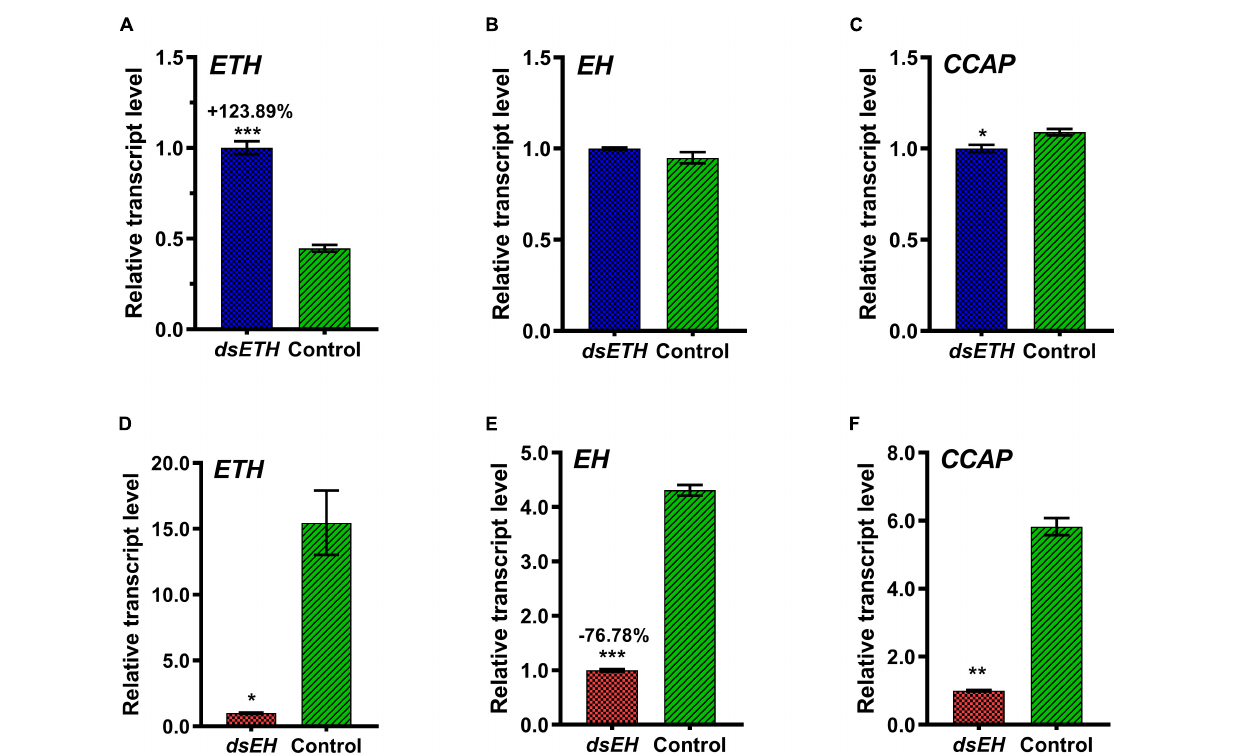
FIGURE 5 | Relative transcript levels of ETH (A) , EH (B) , and CCAP (C) in thoracic ganglia of dsGFP and dsETH -injected crabs at D2 stage were measured. Also, relative transcript levels of ETH (D) , EH (E) , and CCAP (F) in the thoracic ganglia of dsGFP and dsEH -injected crabs at D2 stage were measured. These data represented the mean ± SD. For each sample, three independent pools of five individuals were measured in technical triplicate using real-time quantitative PCR (qRT-PCR). Statistically significant differences between the measurements were found via a t -test with Welch’s correction and are indicated by asterisks (* P < 0.05; ** P < 0.01; *** P <